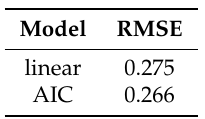
Table 15. Comparison of RMSE between the two